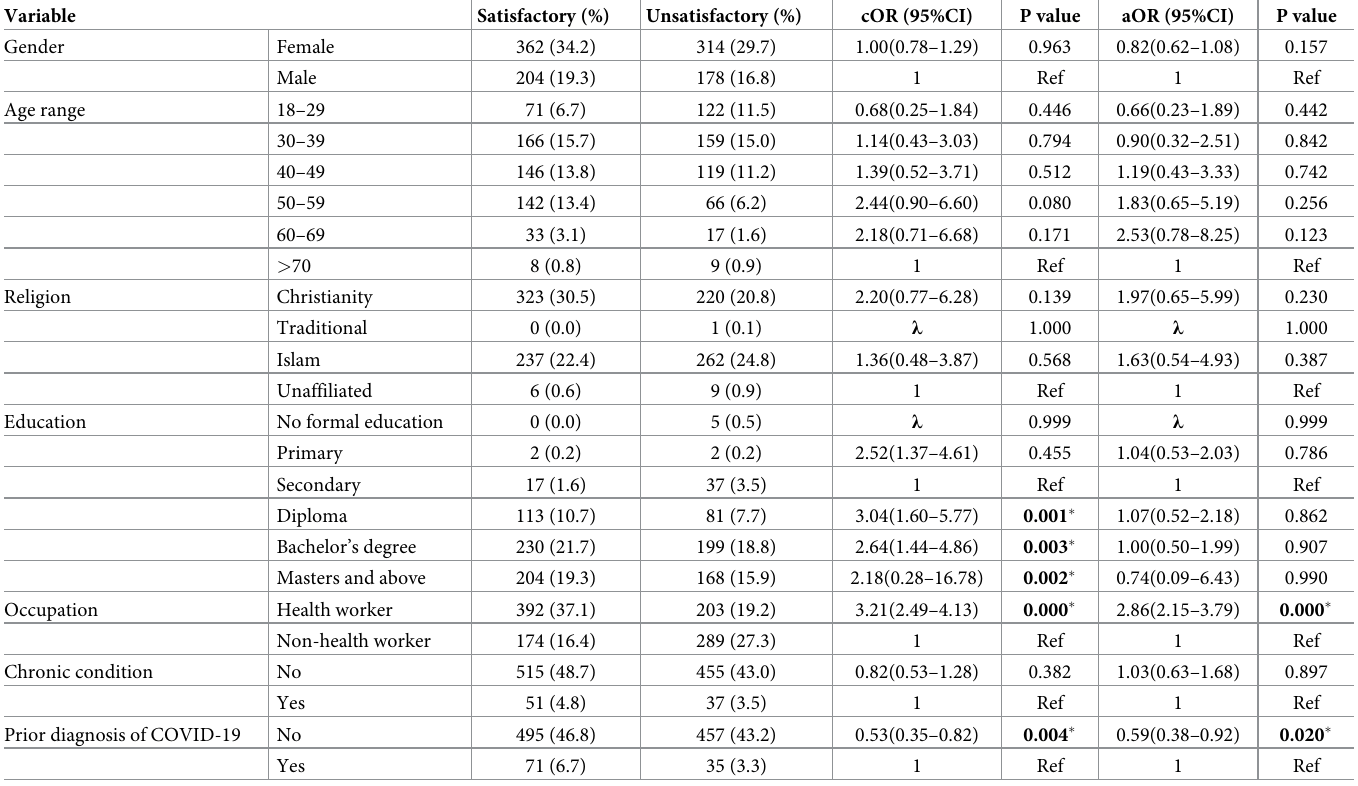
Table 4. Associated sociodemographic factors influencing the perception of COVID-19 vaccination.